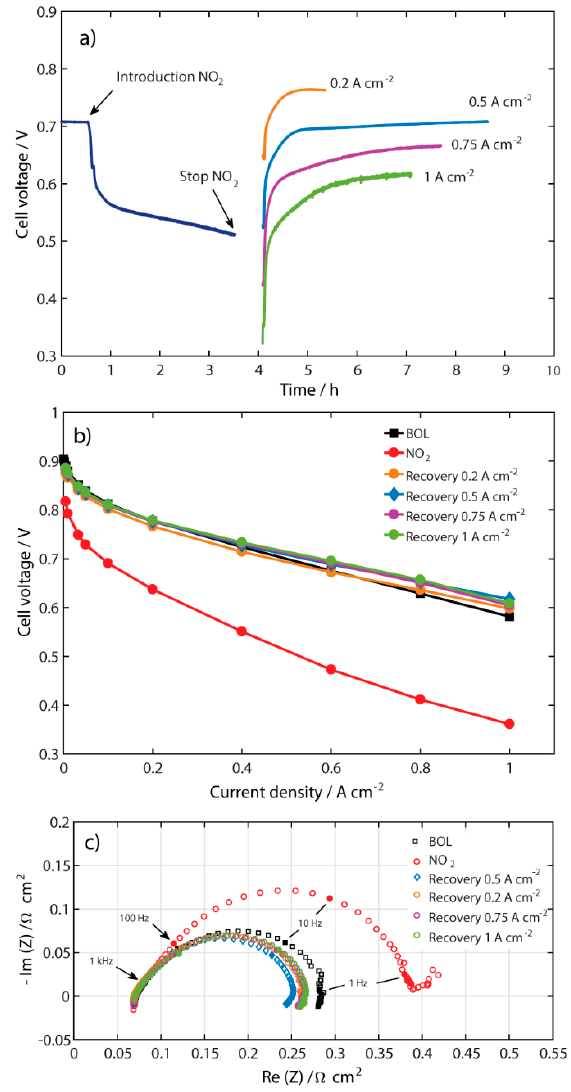
Figure 3. ( a ) Performance with 100 ppm NO 2 and recovery at current densities 0.2, 0.5, 0.75, and 1 A cm − 2 and constant 110 mL min − 1 air flow; ( b ) polarization curves; and ( c ) galvanostatic EIS measurements at 0.5 A cm − 2 at BOL, after contamination, and after recovery at each current density.